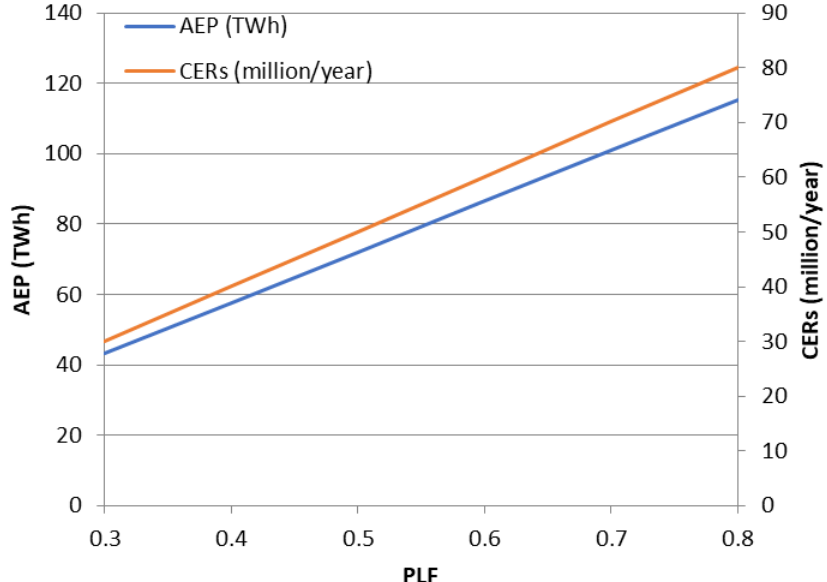
Figure 1. Variation of AEP and CER with